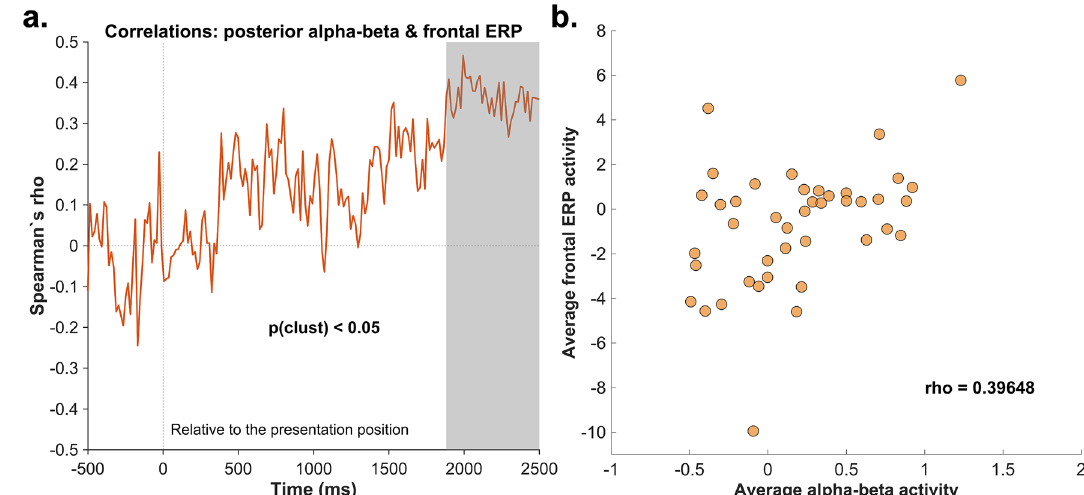
Figure 8. Results of brain-behavior correlations. a. Spearman’s correlation coefficient depicting the correlation between the average contralateral-minus-ipsilateral alpha-beta activity and frontal lateralized ERP effects (the ERP lateralization at channels F9/F10). The gray area reflects the significant cluster ( p < .05) obtained as a result of the cluster-based permutation approach. b. Scatterplot of the negative correlation between the two parameters of interest averaged over the significant